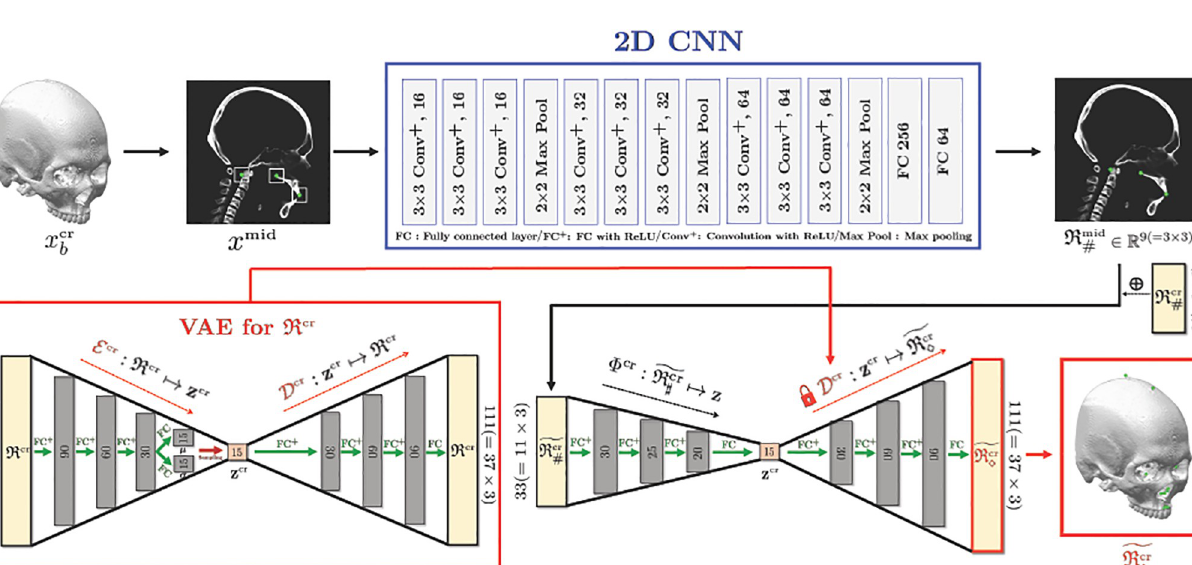
and three landmarks R mid on midsagittal plane that are ] ]